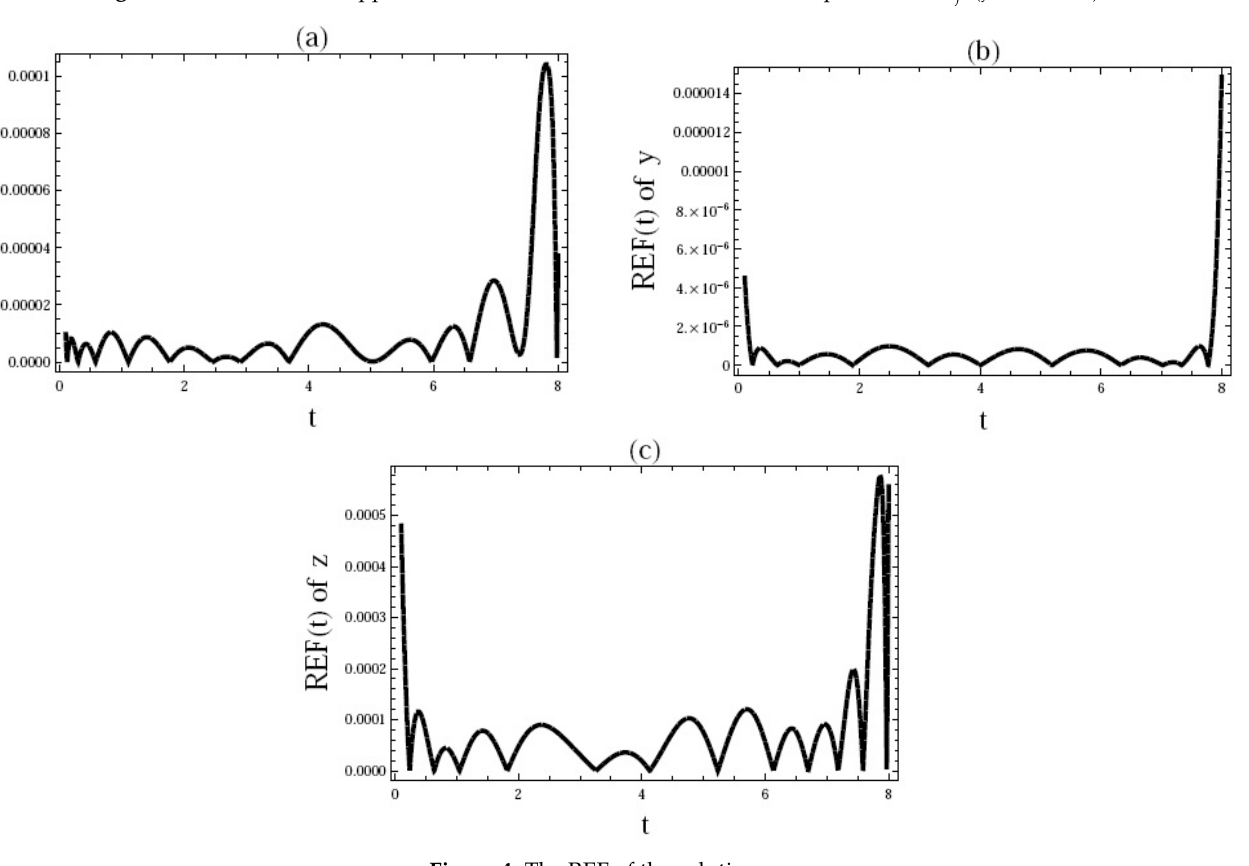
Figure 4. The REF of the